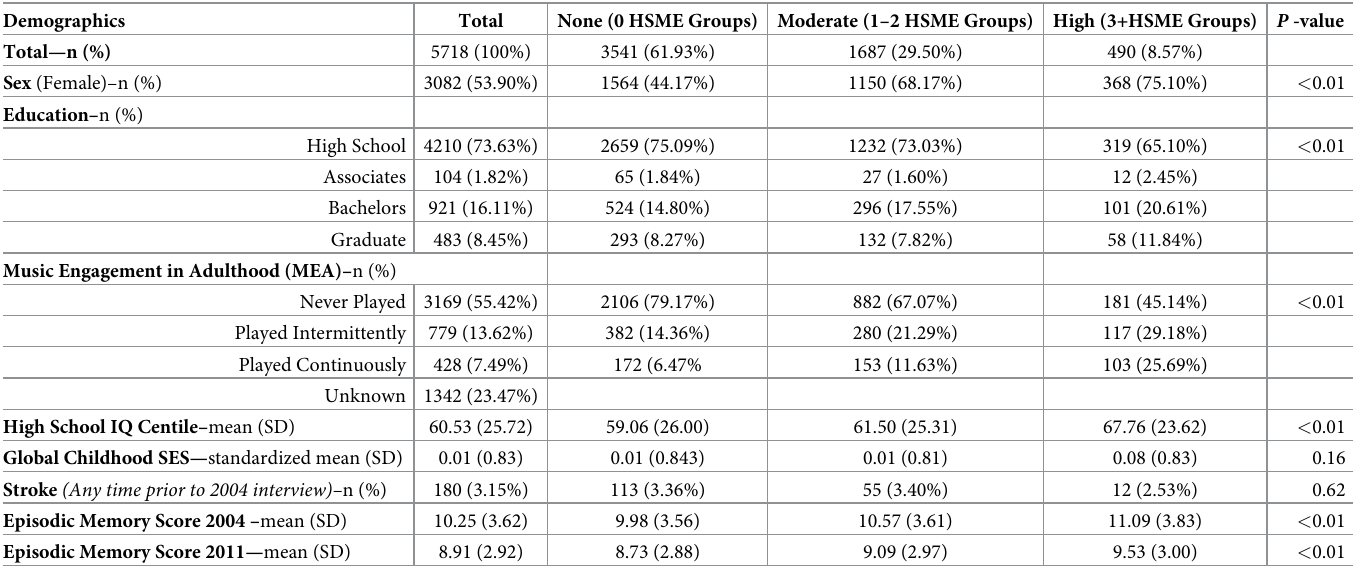
Table 1. Descriptive statistics, demographics by high school music